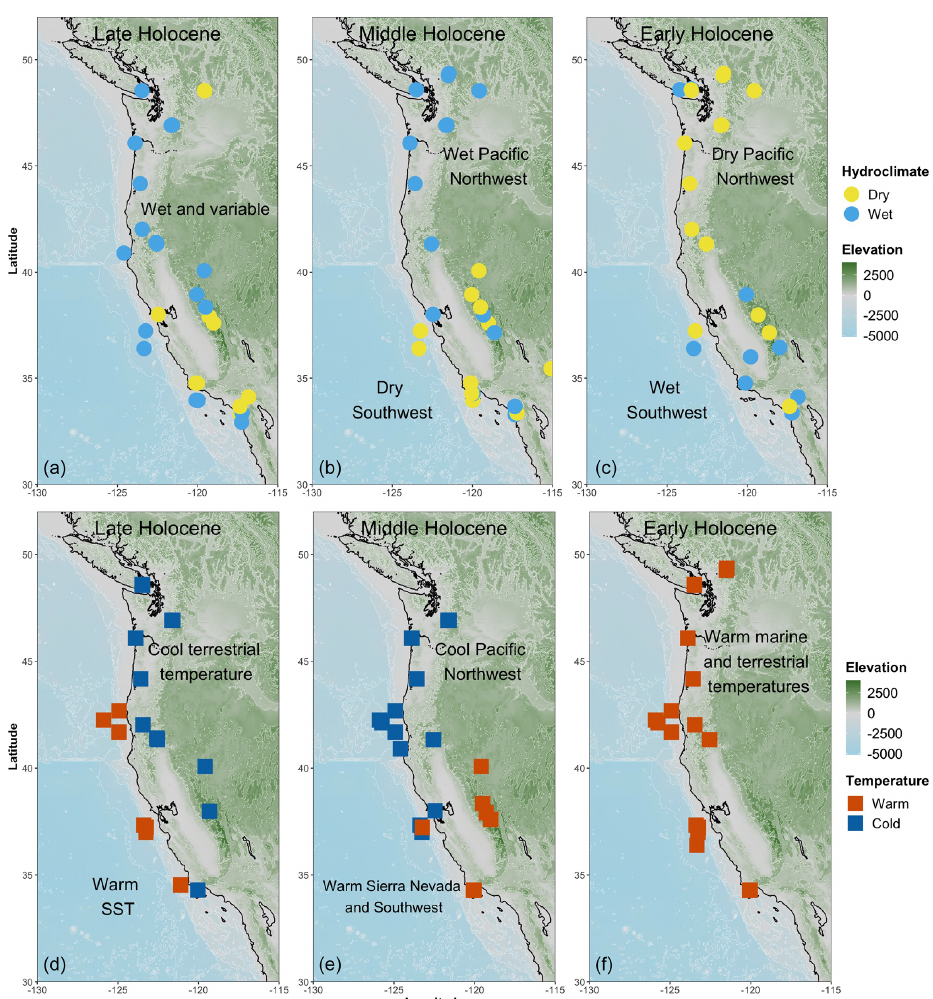
Figure 2. Top panel shows hydroclimate records in Early (11.7–8.2ka, c ), Middle (8.2–4.2ka, b ), and Late (4.2–0ka, a ) Holocene: yellow dots represent dry conditions and light blue represents wet conditions. Bottom panel shows temperature records from Early (f) , Middle (e) , and Late (d) Holocene: dark blue squares represent cold temperatures and orange represents warm